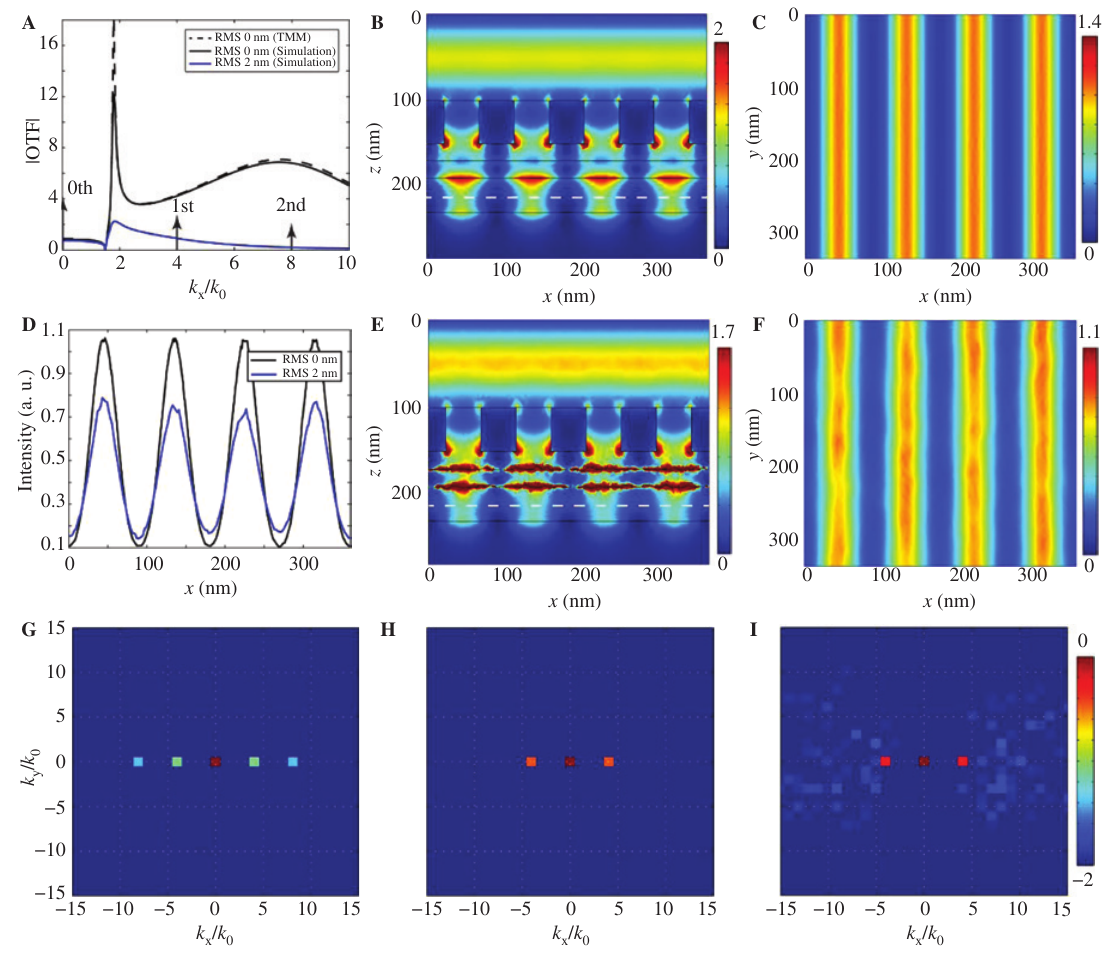
Figure 2: Effects of the rough film in superlens lithography system. (A) OTF curves of a single Ag film with smooth and rough surfaces calculated by TMM and numerical simulation. The arrows show the posi- tions of diffraction orders of the grating mask in k -space. (B) Side view and (C) top view of the normalized electric field intensity distribu- tions with smooth Ag film (RMS = 0 nm); (E, F) corresponding simulation results with rough Ag film (RMS = 2 nm); (D) normalized electric field intensity distribution of the patterns in the PR film at the dashed line positions in (B) and (E). (G) A series of diffraction orders in k -space generated from the grating with a period of 90 nm. The distributions of diffraction orders in PR film after transmitted through a single Ag film with the roughness of (H) 0 nm and (I) 2 nm, respectively. The logarithm scale is used in